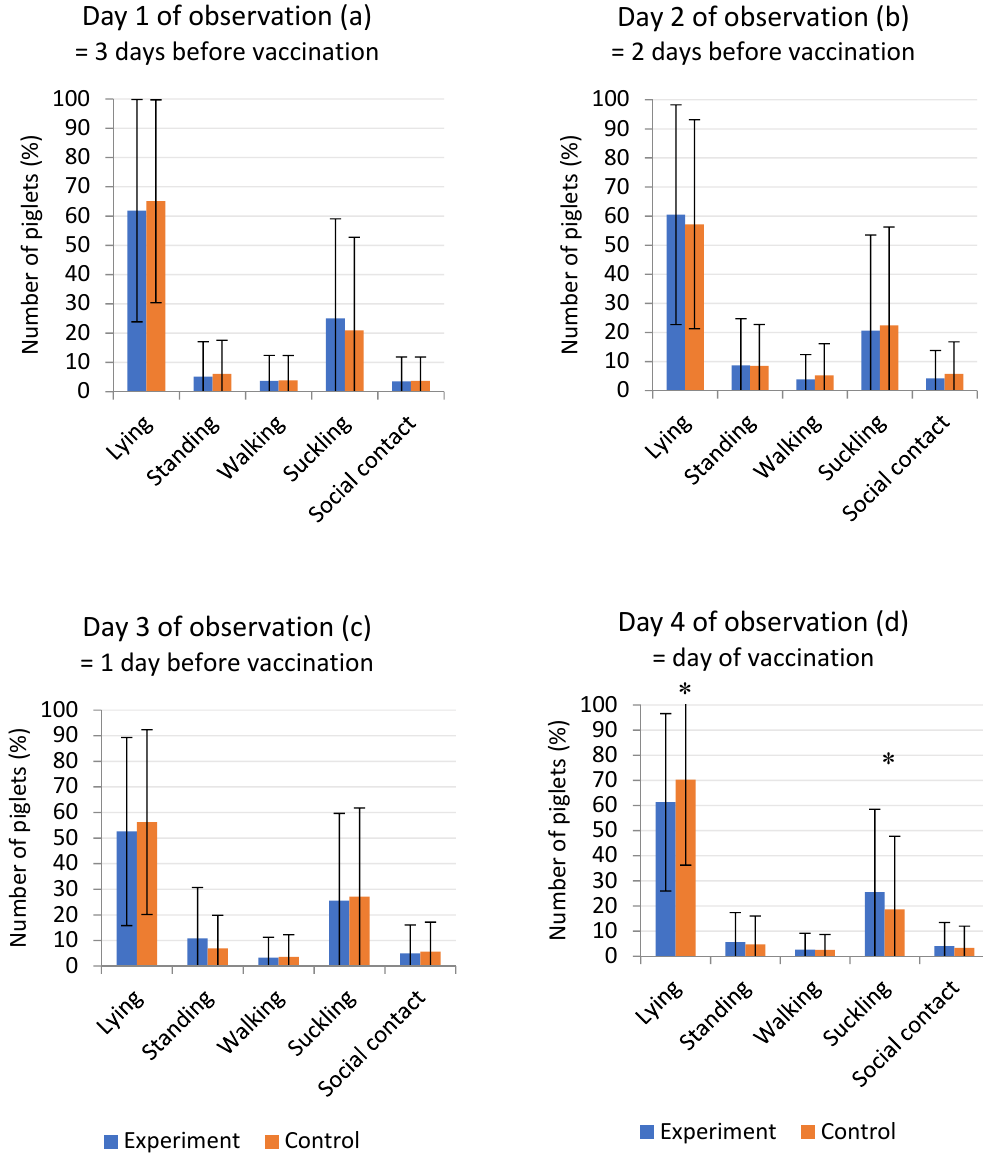
Figure 1. Percentage of piglets per litter (means and standard deviations) showing different behaviors in experimental and control groups on the three days before vaccination ( a – c ), as well as on the day of vaccination ( d ). * p < 0.0001.